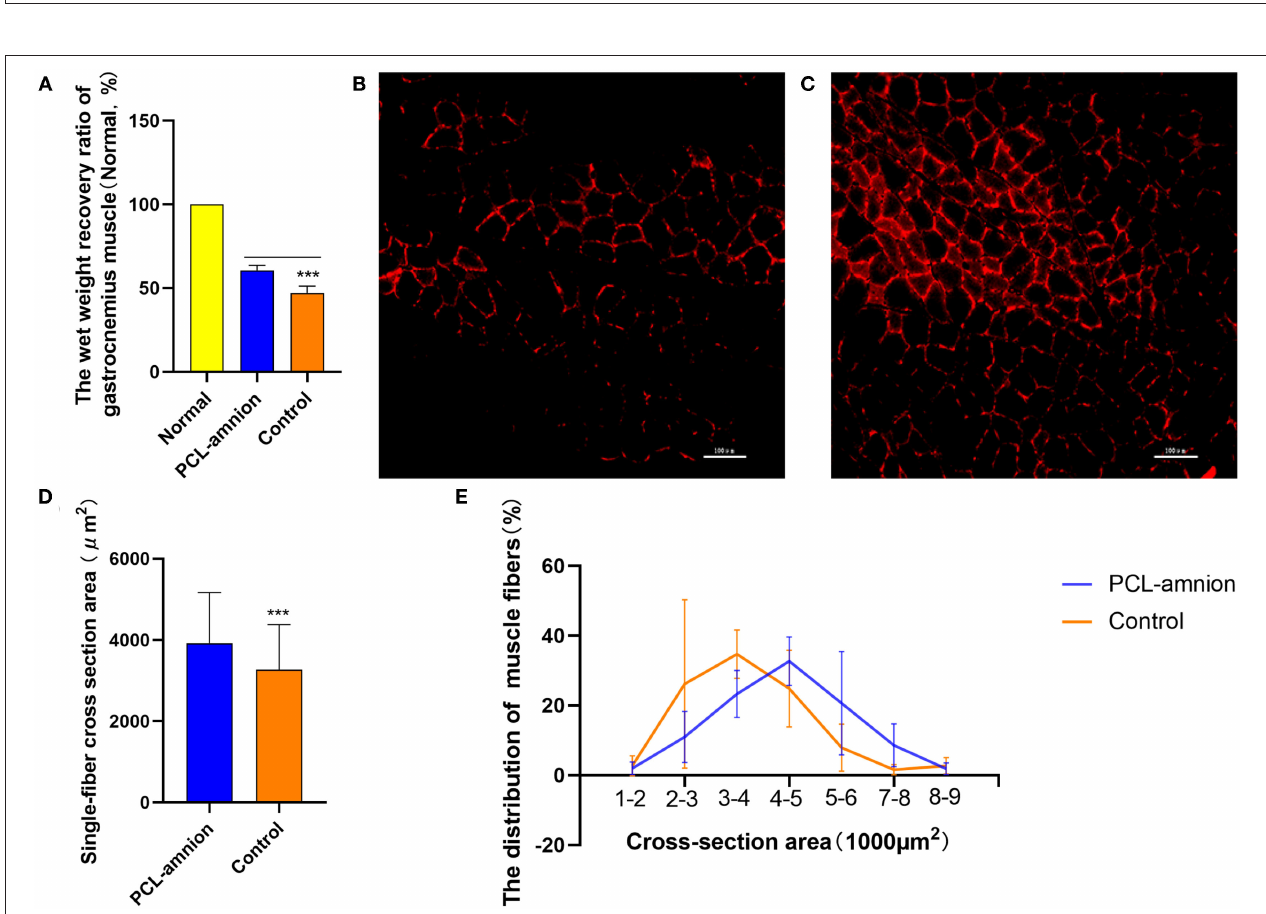
FIGURE 7 | Gastrocnemius muscle analysis. (A) Wet weight recovery ratio of gastrocnemius muscle in the PCL-amnion nanofibrous membrane group is significantly higher in comparison with the control group ( P < 0.05). (B) The PCL-amnion nanofibrous membrane group. (C) The Control group. (D) Average single-fiber CSA. The PCL-amnion nanofibrous membrane group shows significantly greater single-fiber CSA in comparison with the control group ( P < 0.05). (E) Distribution of single-fiber CSA. *** P < 0.001 compared to the PCL-amnion group.